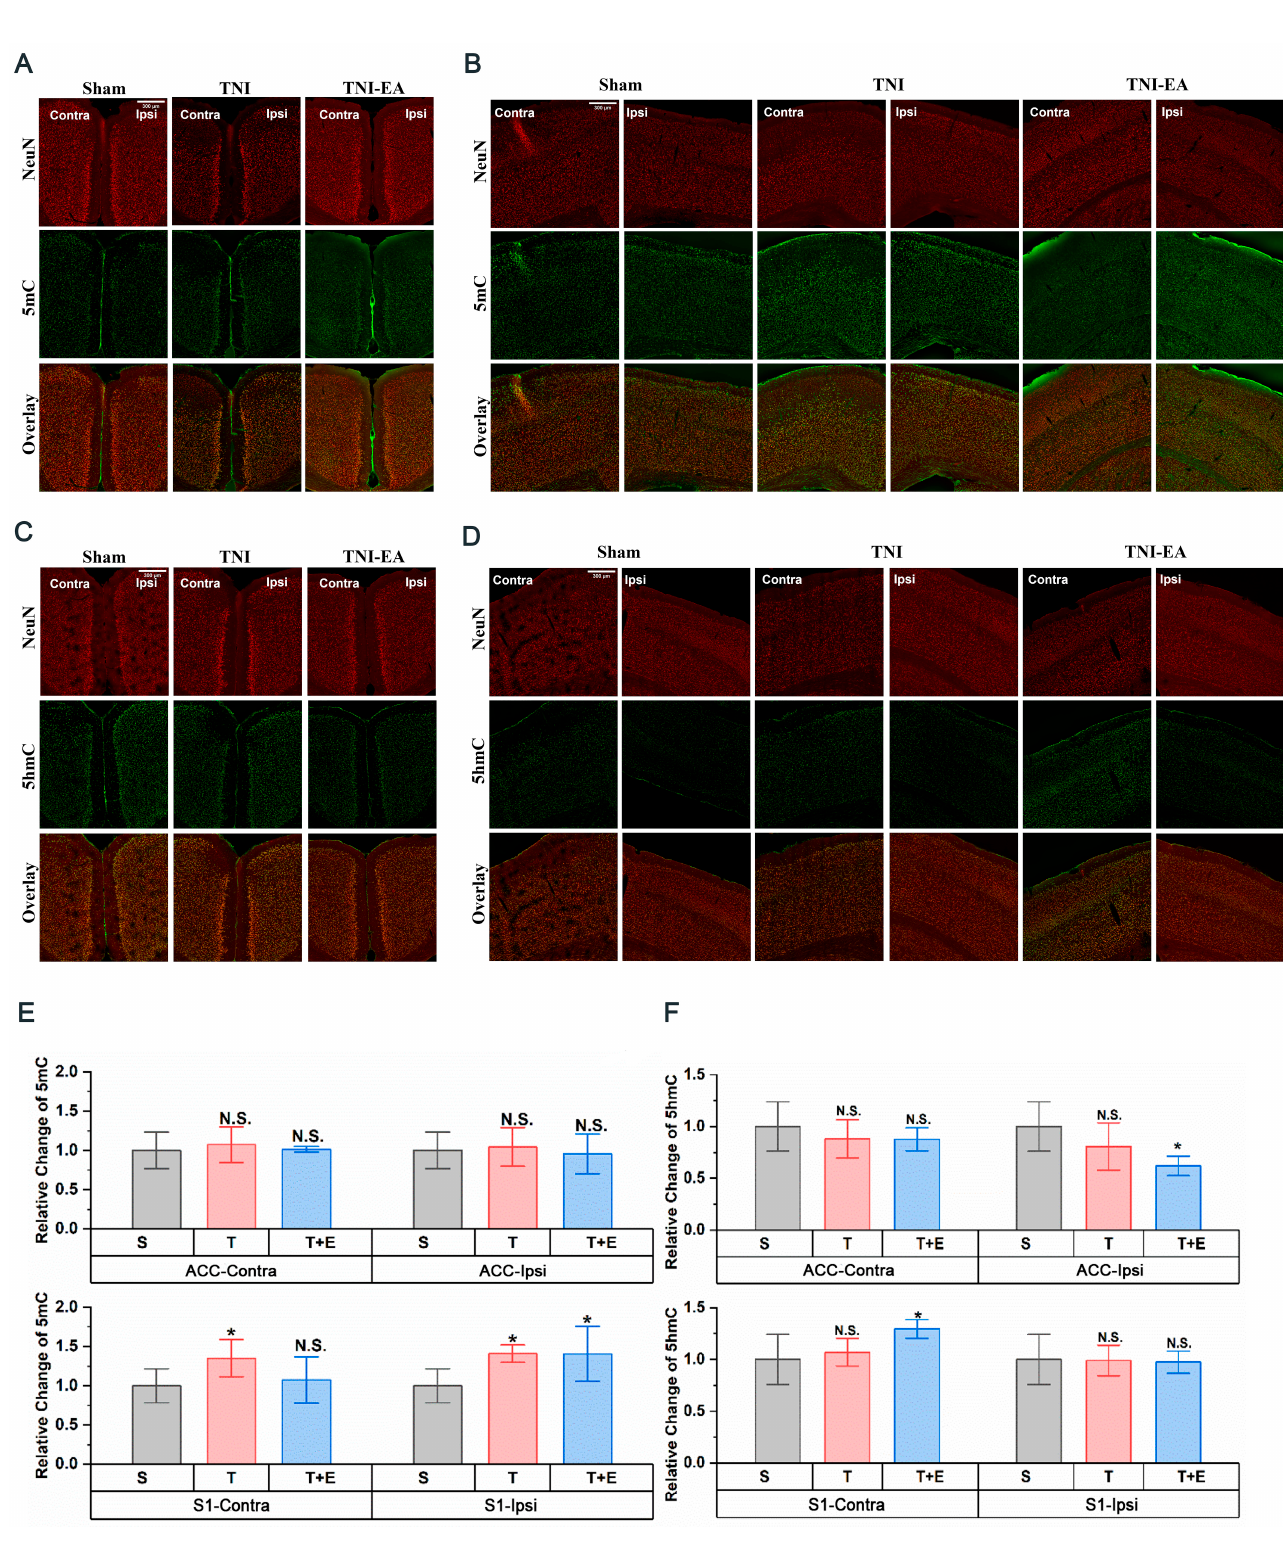
Figure 2. Immuno fl uorescence of brain slices. Representative 10× confocal images of ( A , B ) 5mC and ( C , D ) 5hmC of Sham, TNI, and TNI-EA group at ACC region ( A , C ) and S1 regions ( B , D ). ( E , F ) Relative change in 5mC ( E ) and 5hmC ( F ) level of each group at ACC and S1 regions. Scale bar = 300 µm. N = 4. N.S.: no signi fi cance compared with Sham group. *: p < 0.05 compared with Sham group.